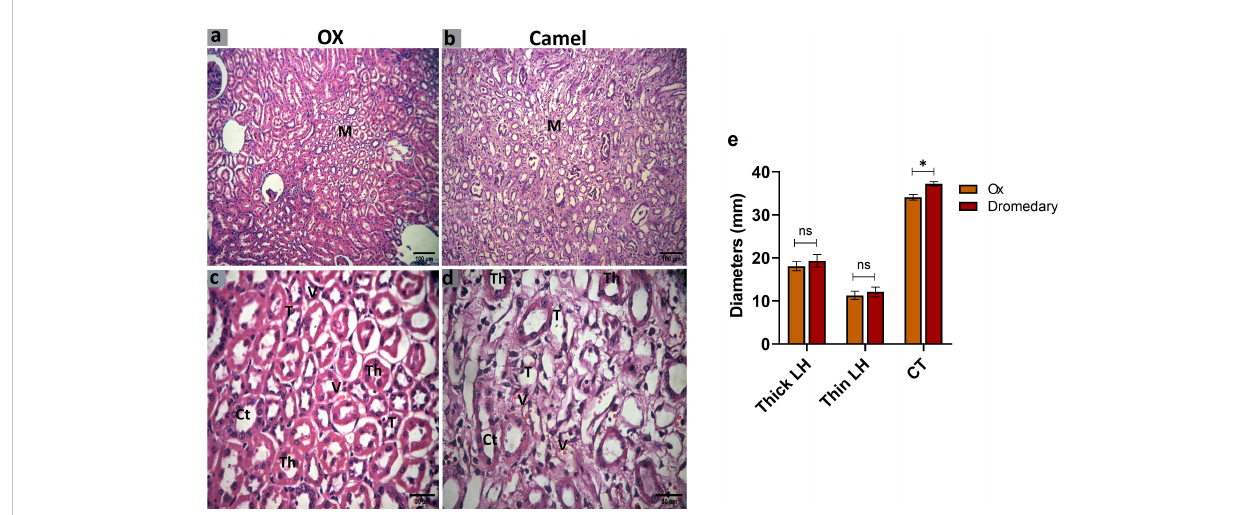
FIGURE 8 Histologic sections of the oxen and dromedary kidney show that the dromedary kidney contains wider CTs. The renal medulla (M) of the oxen and dromedary ( A , B , respectively). Scale bar, 100 m m; hematoxylin and eosin stain. collecting tubules-CT, the thin segment of the loop of Henle-T, the thick segment of the loop of Henle-Th, and vasa recta-V. The renal medulla of the oxen and dromedary ( C , D , respectively). Scale bar, 30 m m; hematoxylin and eosin stain. (E) Morphometry analysis for diameters of thin and thick segments of the loop of Henle, and CT. Data shown are represented as mean ± SD.* p <0.05.